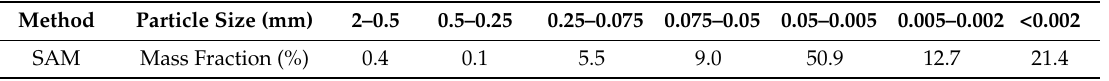
Table 1. Particle size distribution of selected